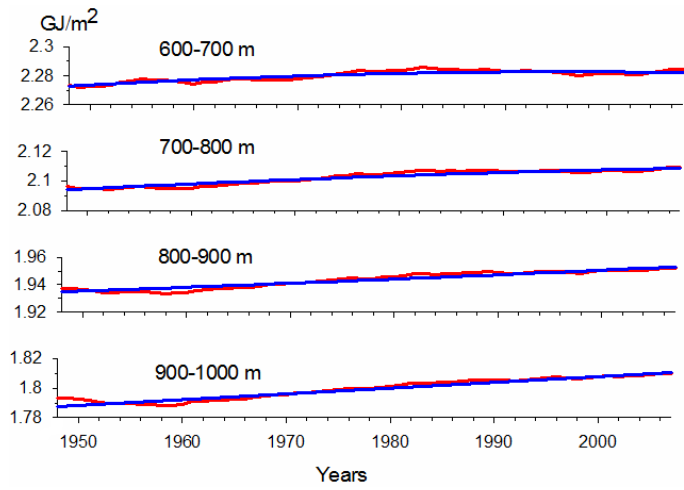
Figure 4. Time series of the WO heat content and its quadratic trend for the period of 1948–2007 in the active upper layer (its deep part): 600–700, 700–800, 800–900, 900–1000 m.